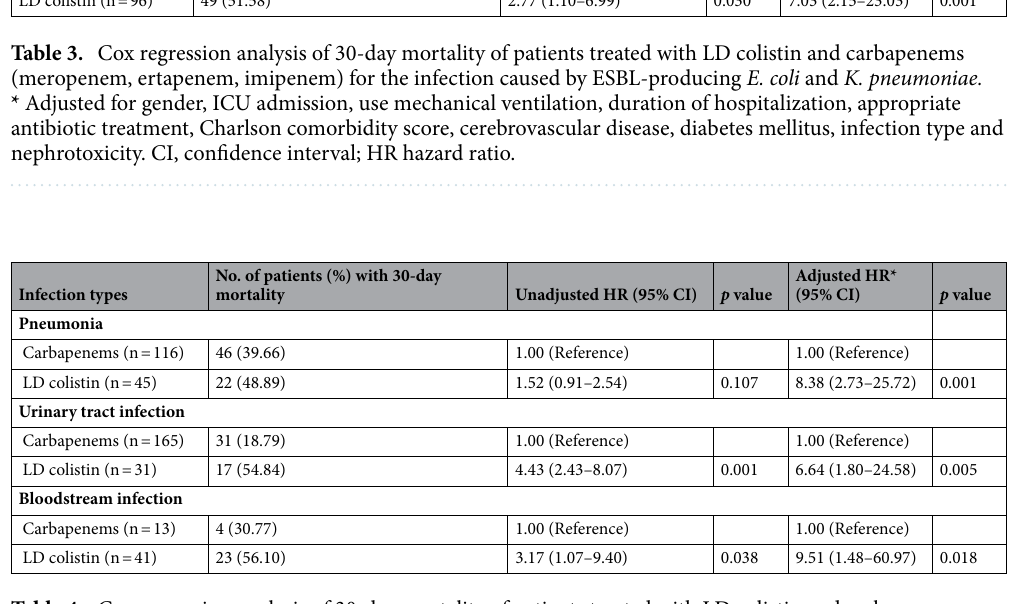
Table 4. Cox regression analysis of 30-day mortality of patients treated with LD colistin and carbapenems for the infection types caused by ESBL-producing E. coli and K. pneumoniae. * Adjusted for gender, ICU admission, use mechanical ventilation, duration of hospitalization, appropriate antibiotic treatment, Charlson comorbidity score, cerebrovascular disease, diabetes mellitus, infection type and nephrotoxicity. CI, confidence interval; HR hazard